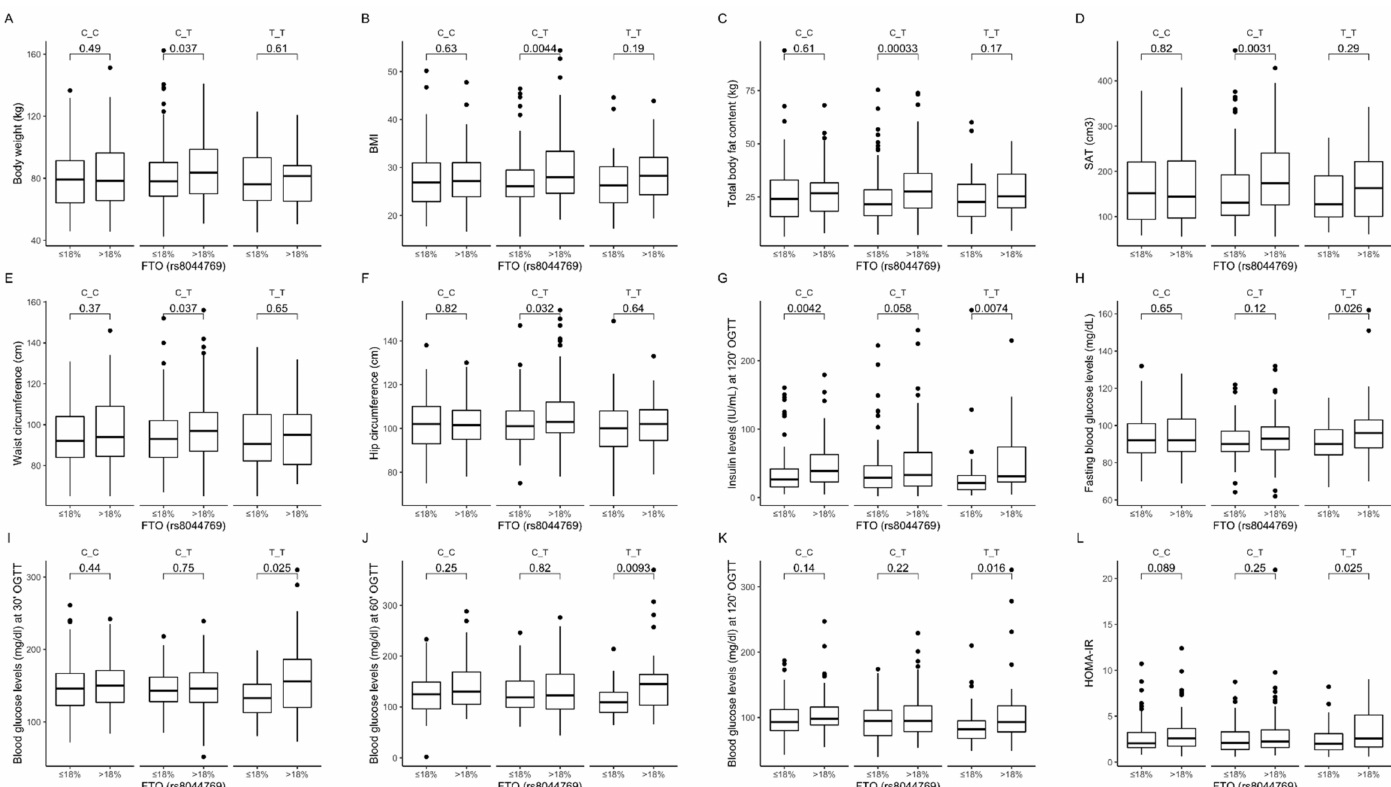
Figure 11. Association of dietary protein intake ≤ 18% and > 18% of total daily energy intake with ( A ) body weight (kg); ( B ) BMI (kg / m 2 ); ( C ) total body fat content (kg); ( D ) SAT (cm 3 ); ( E ) waist circumference (cm 3 ); ( F ) hip circumference (cm 3 ); ( G ) insulin level (IU / mL) at 120 min of OGTT; ( H ) fasting blood glucose level (mg / dL); blood glucose level (mg / dL) at ( I ) 30 min, ( J ) 60 min, and ( K ) 120 min of OGTT; and ( L ) HOMA-IR in FTO rs8044769 genotype